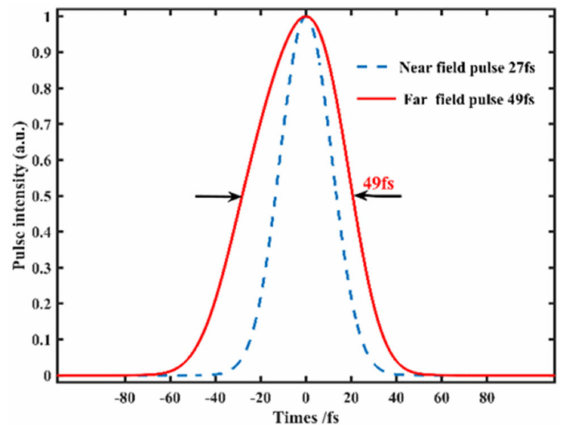
Figure 6. Near field partial and far field pulse durations of the 200 TW